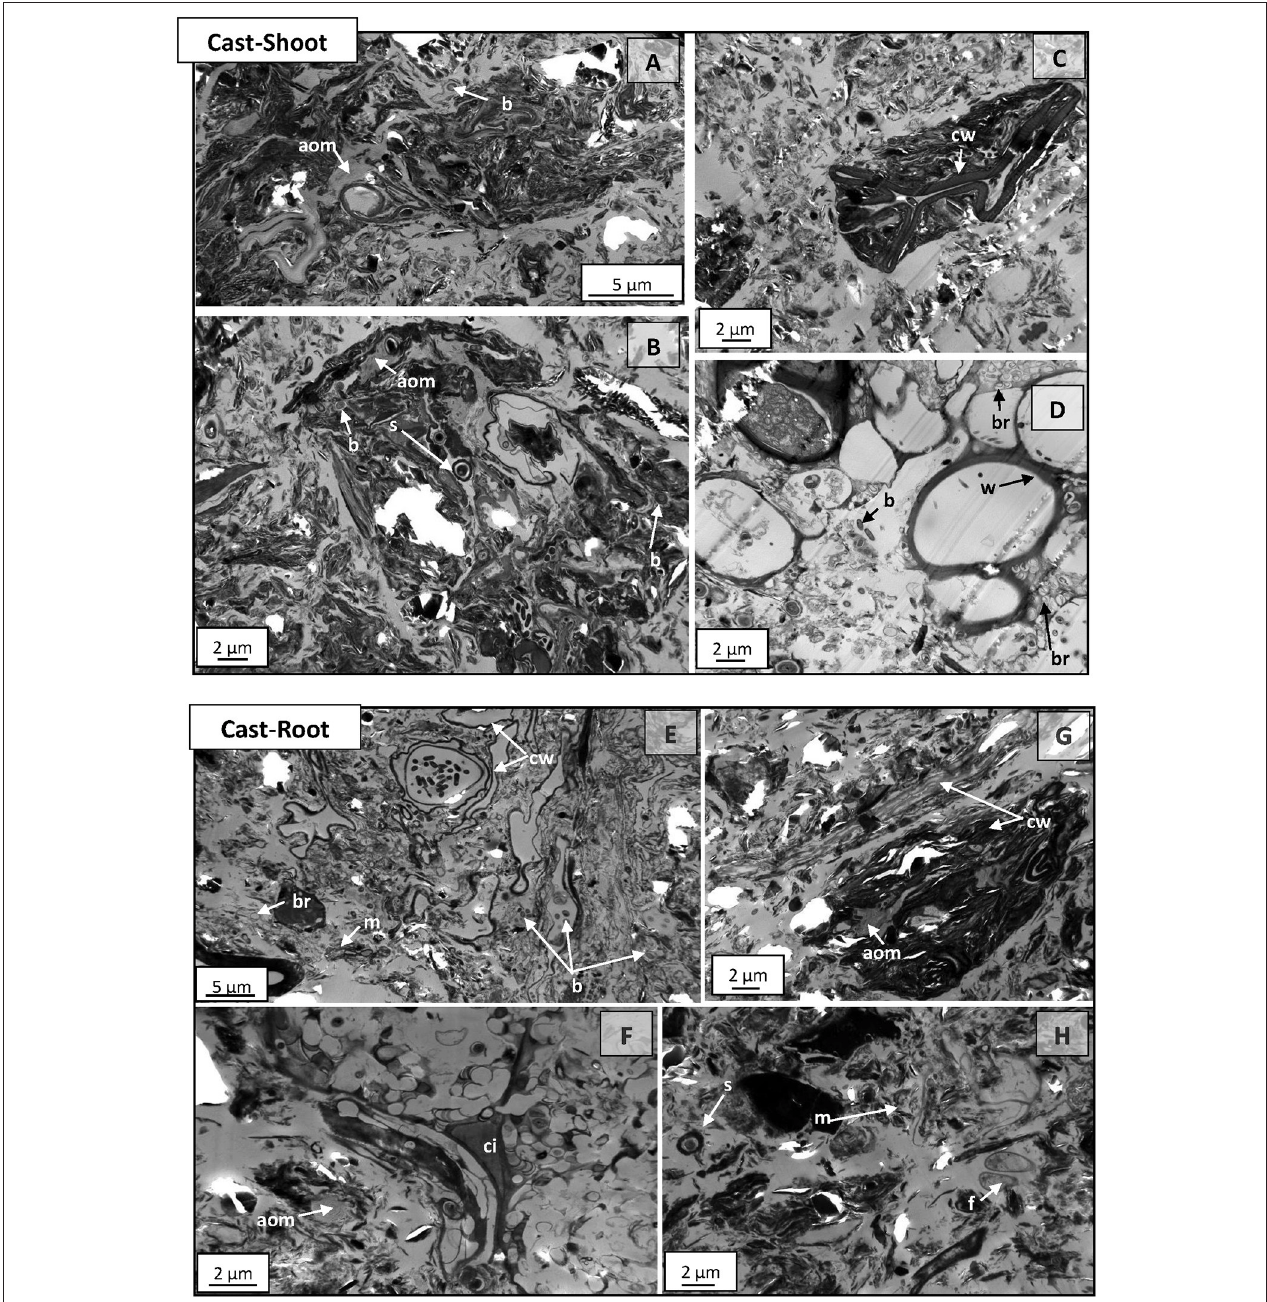
FIGURE 5 | TEM micrographs of Cast-Shoot and Cast-Root samples after 54 weeks of experiment. (A–C,G) organo-mineral aggregates; (D) partially degraded woody tissues; (E) cell walls residues; (F) highly degraded cells with the cell intersection left; (A,B,D,E,H) microorganisms. aom, amorphous organic matter; b, bacteria; br, bacterial residue; cw, cell wall; ci, cell intersection; f, fungus; m, mineral particle; s, bacterial spore; w, woody tissue.